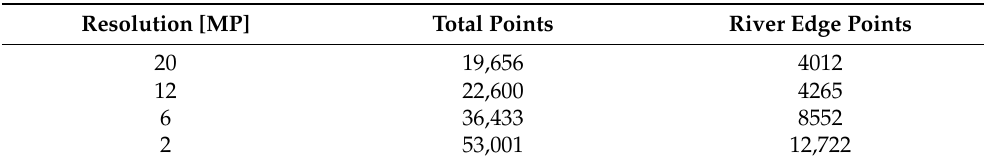
Table 2. The number of detected points within the point cloud and the points associated with the river’s edge in relation to the image